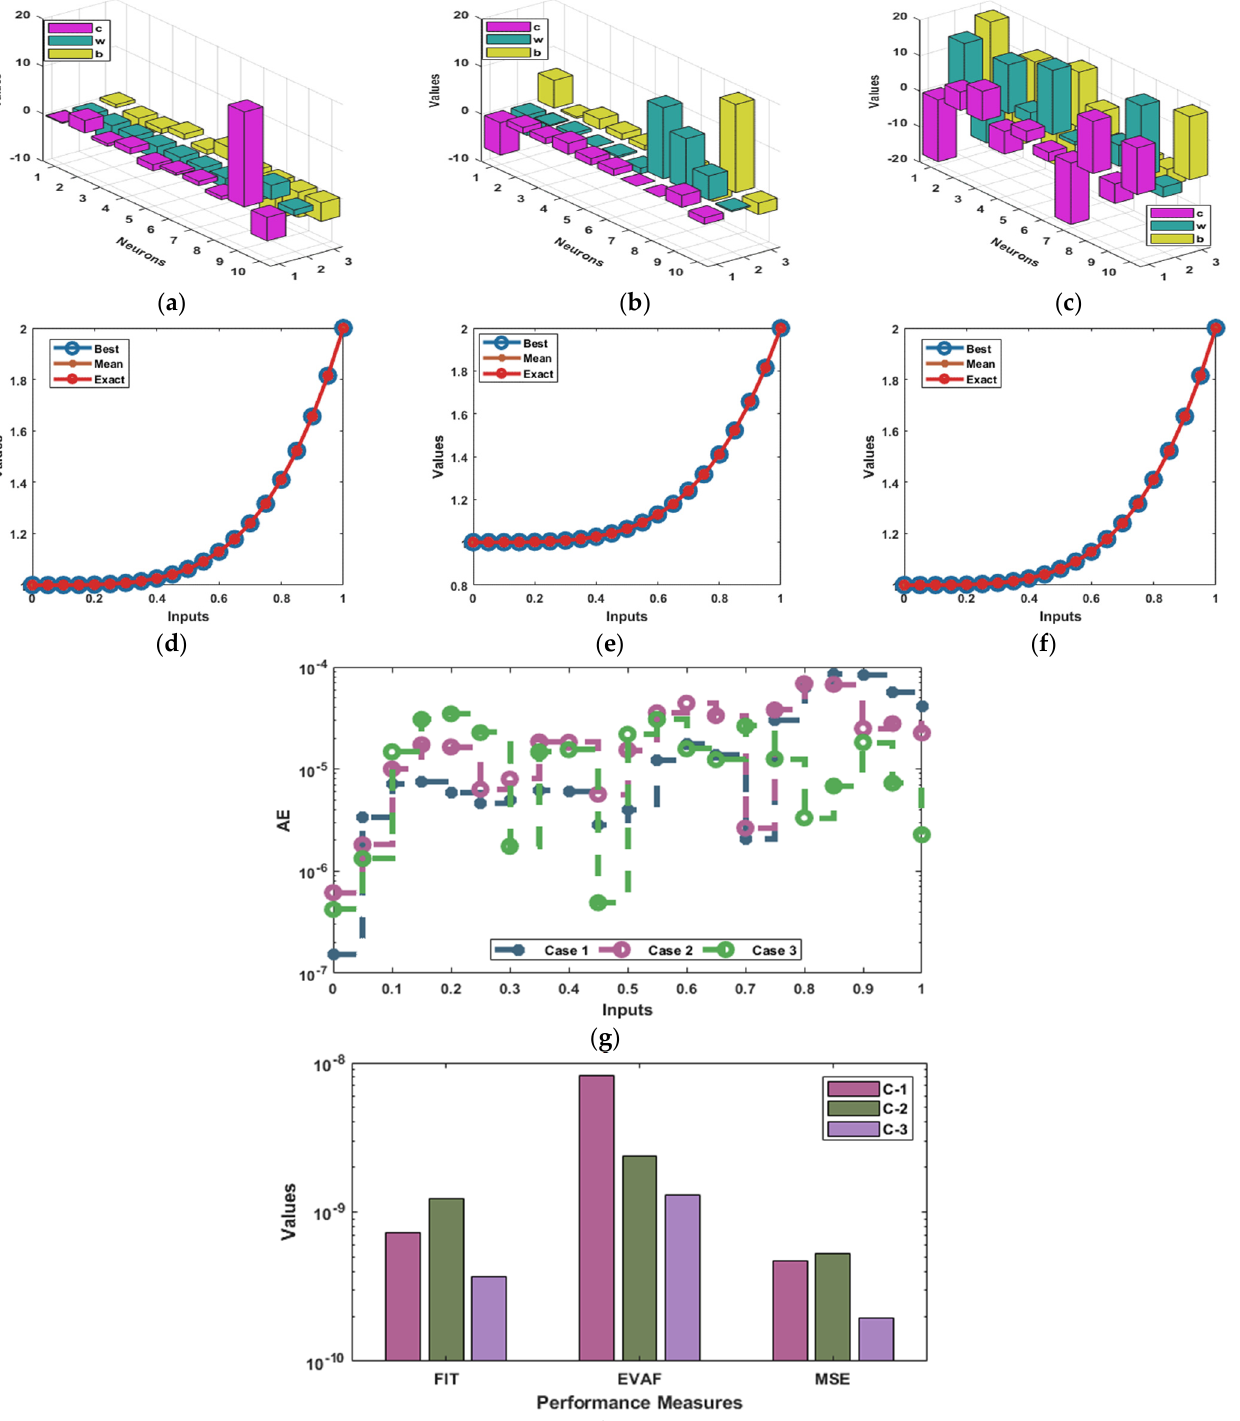
Figure 3. Graphic illustrations based on the best weight vectors, AE, and convergence performances to solve the NSPM-SK. ( a ) Weights for C-1. ( b ) Weights for C-2. ( c ) Weights for C-3. ( d ) C-1: Results. ( e ) C-2: Results. ( f ) C-3: Results. ( g ) Performances of the AE for the NSPM-SK. ( h ) Performance indices for the NSPM-SK.